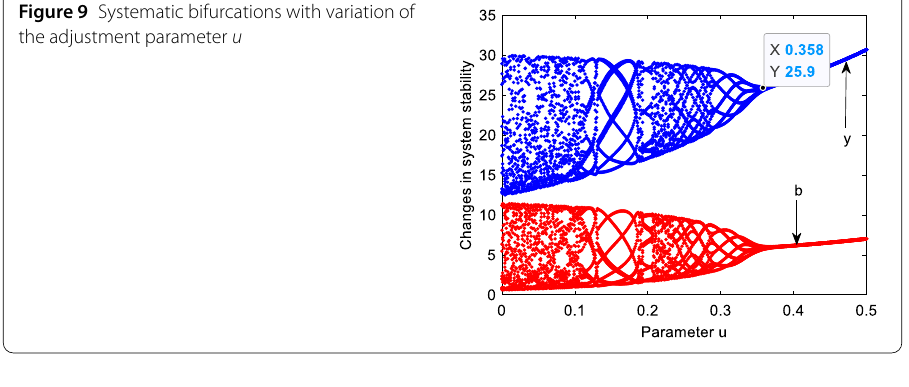
Figure 10 Systematic bifurcations with variation of adjustment parameter